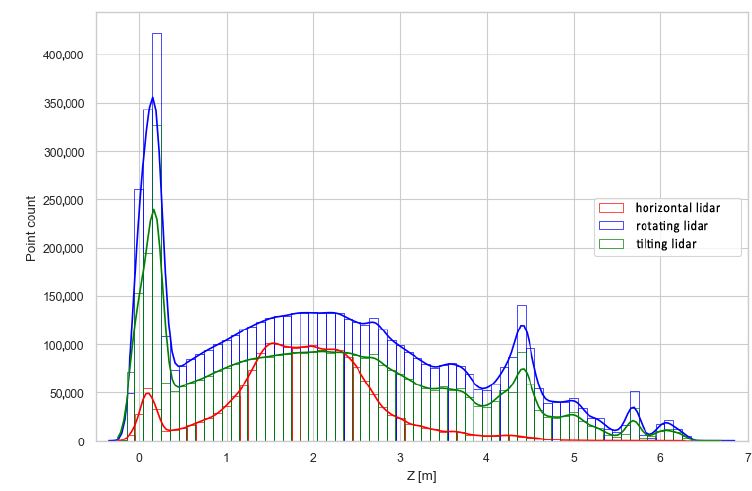
Figure 13. Distribution of points along the z -axis—absolute values.